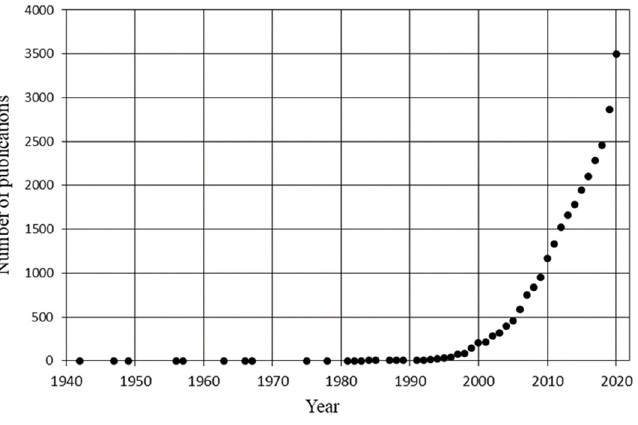
Figure 2. Increase in the number of publications regarding polyphenols and antioxidants in the past 100 y. Publications are those registered in the Scopus database (October 2021). Results retrieved from the query “Polyphenols” and the query “Polyphenols” and “Antioxidant”.